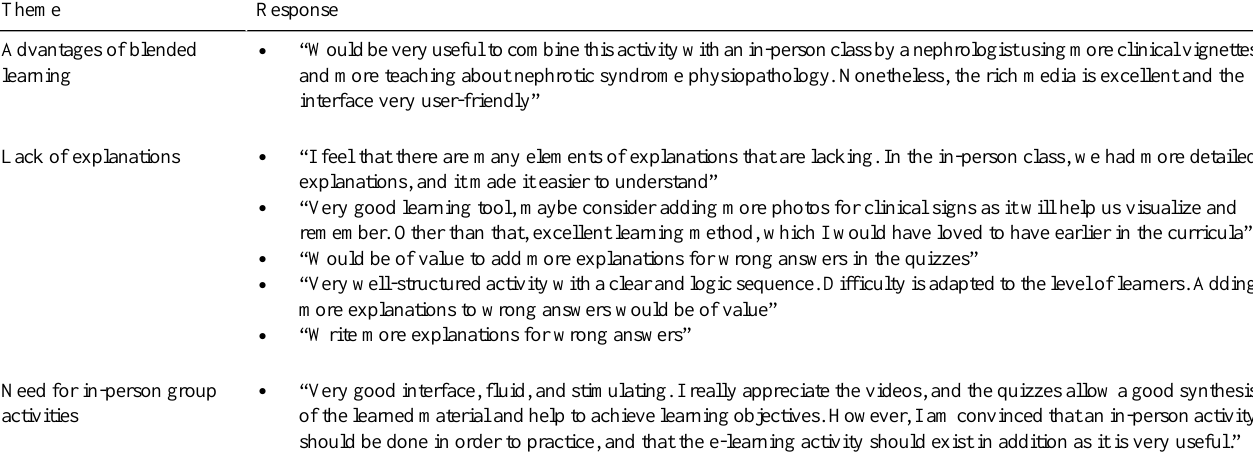
Table 4. Advanced learners’qualitative inputs (translated from